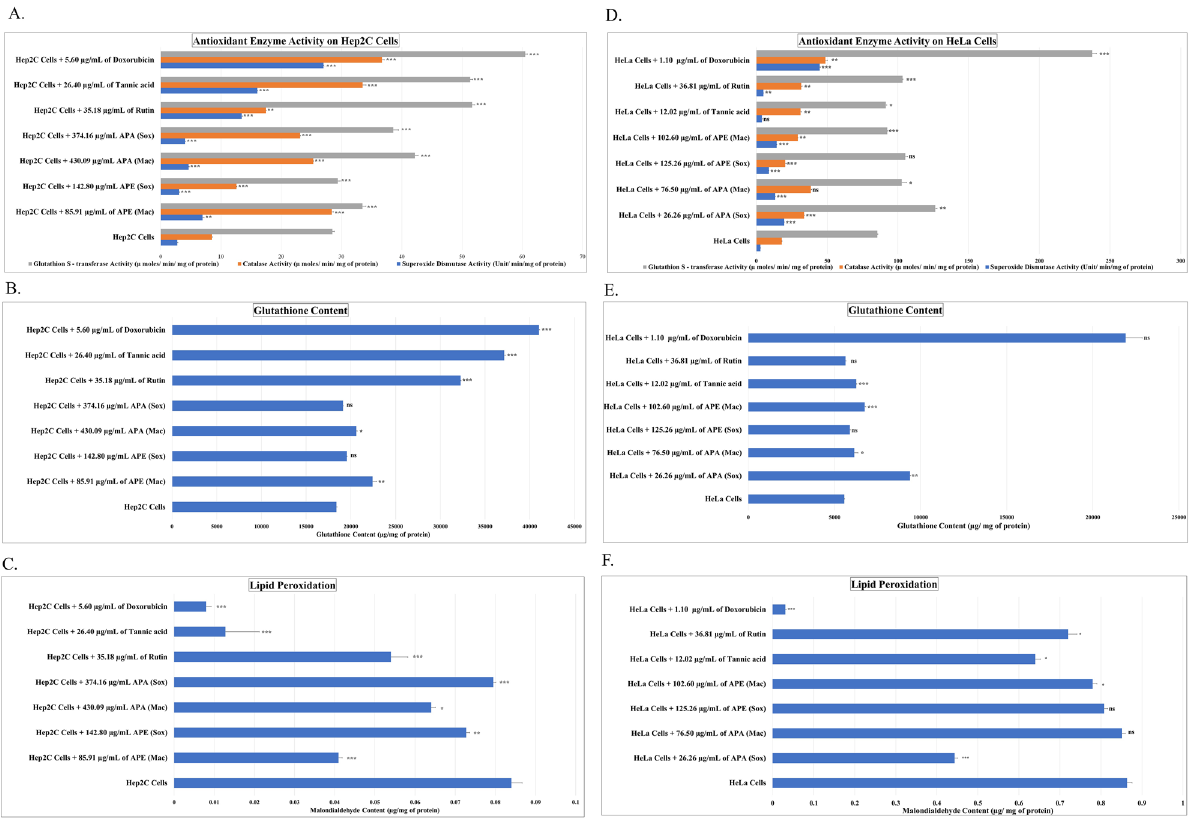
Figure 6. Antioxidant enzyme activity of A. precatorius seed extracts on Hep2C and HeLa cells illustrating (A) ; SOD, CAT & GST activity in Hep2C Cells, (B–C) ; non-enzyme content (GSH and MDA) in Hep2C Cells, (D) ; SOD, CAT & GST activity in HeLa Cells and (E–F) ; non-enzyme content (GSH and MDA) in HeLa Cells. The data is representative of three consecutive experiments. * p < 0.05, ** p < 0.01, *** p < 0.001, ns = 0.44 ± 0.01 µg/mg of protein as compared to untreated (control), rutin and tannic acid, although cells treated with doxorubicin had much lower MDA content i.e., 0.031 ± 0.16 µg/mg of protein (Fig. 6F).